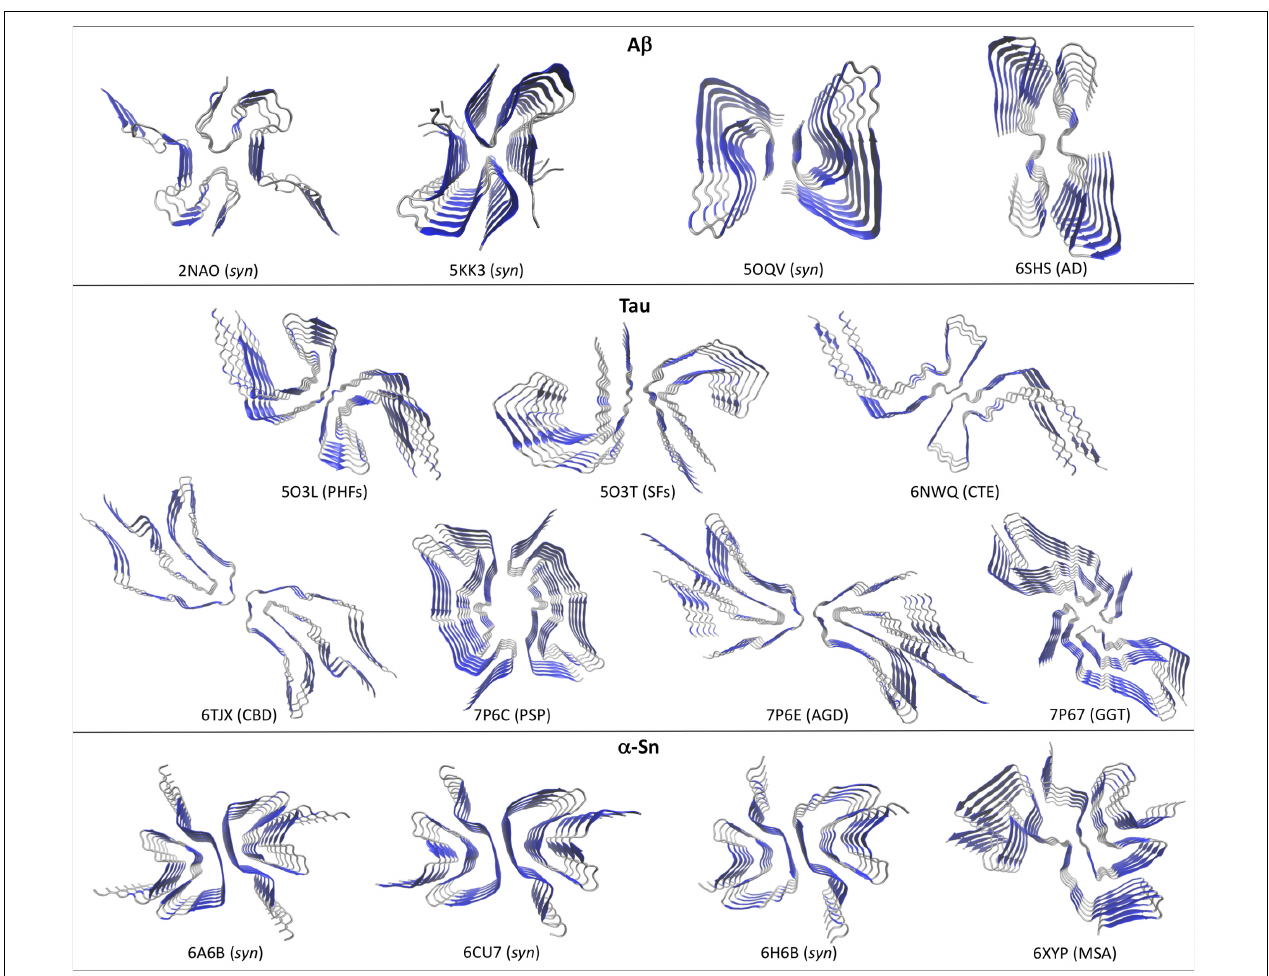
FIGURE 1 | Different high-resolution structures of A β , Tau, and α -Sn in the amyloid state. Top views are shown to highlight the two-fold symmetry arrangement of the protofilaments. A β : 2NAO, 5KK3, and 5OQV are synthetic A β 42 fibrils ( syn ); 6SHS are brain-derived Type II A β 40 fibrils from AD. Tau: 5O3L and 5O3T are respectively, ex vivo PHFs and SFs from AD; 6NWQ, 6TJX, 7P6C, 7P6E, and 7P67 are ex vivo Type II filaments from CTE, CBD, PSP, AGD, and GGT, respectively. α -Sn: 6A6B, 6CU7, and 6H6B are synthetic fibrils ( syn ); 6XYP are brain-derived Type I fibrils from MSA. Beta-sheets are depicted in blue and coils and α -helices in